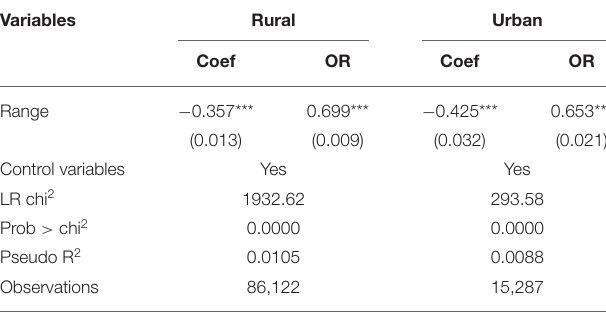
TABLE 5 | Heterogeneous effects of migration distance by household register.